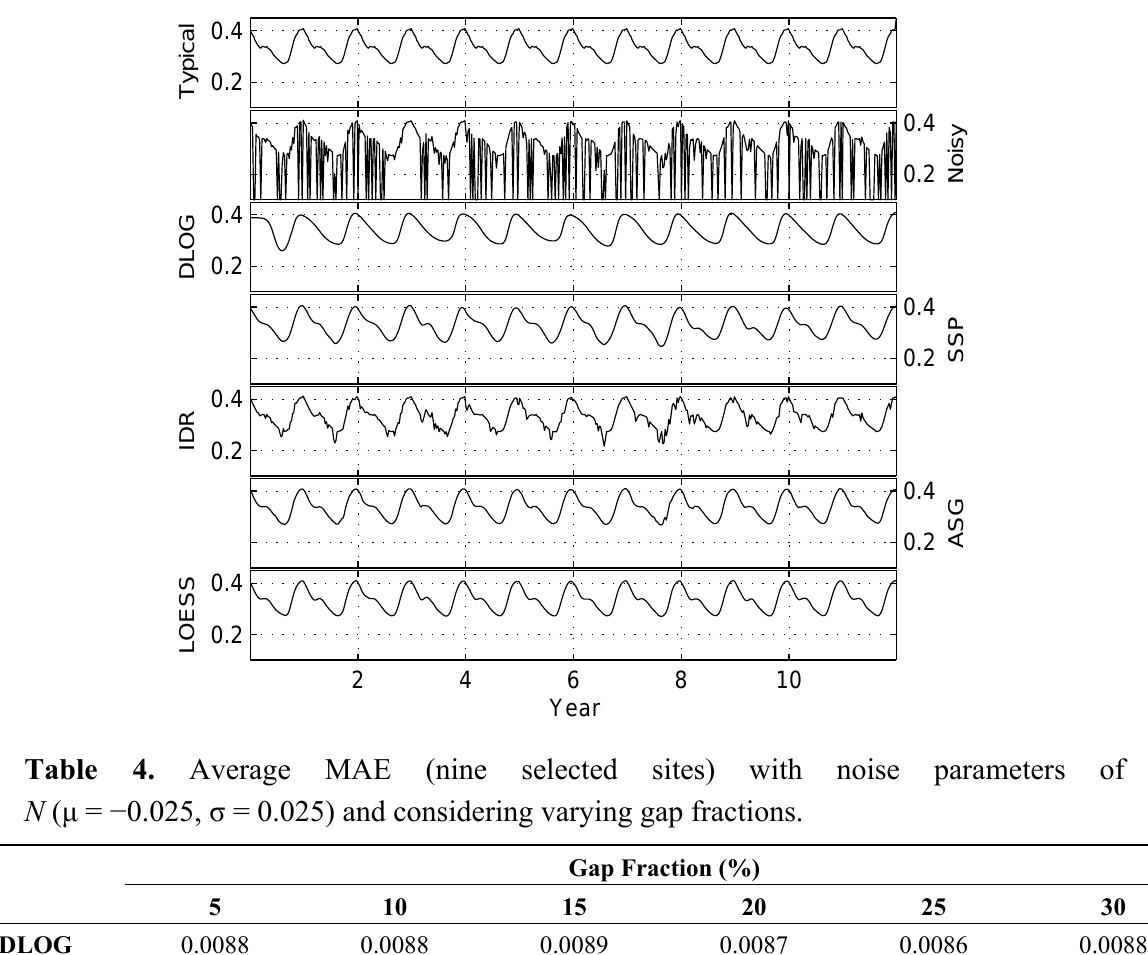
Figure 6. Reconstructed fAPAR series corresponding to a mixed forest area. The original fAPAR (top) is followed by the noisiest scenario with N ( μ = − 0.25, σ = 0.25) in 25% of the points and a 15% of missing data for the four filtered signatures.